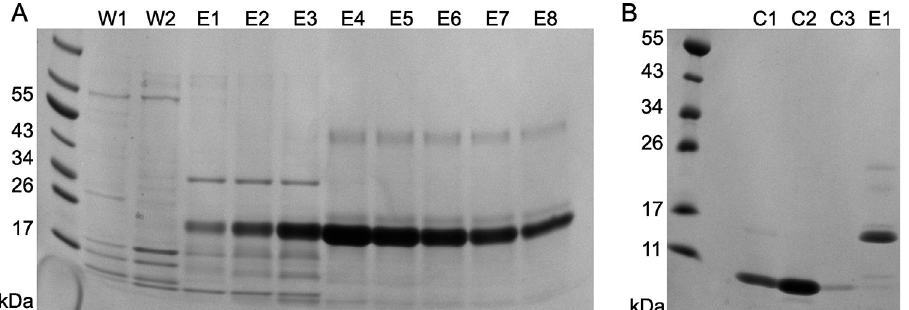
Fig 1. Purification of CXCL8. (A) SDS-PAGE analysis of CXCL8-SUMO3 nickel affinity purification. The lanes are labelled wash (W1 and W2) and elution (E1-E8). (B) SDS-PAGE gel analysis of nickel affinity purification of CXCL8 post SUMO3 tag digestion. The lanes are labelled CXCL8 elution (C1-C3), and elution (E1). CXCL8 is separated in the wash step from tagged ULP1, undigested CXCL8-SUMO3 and the SUMO3 tag. The molecular weights are as follows; CXCL8-SUMO3–20 kDa, CXCL8–8.4 kDa and SUMO3–11.7 kDa.